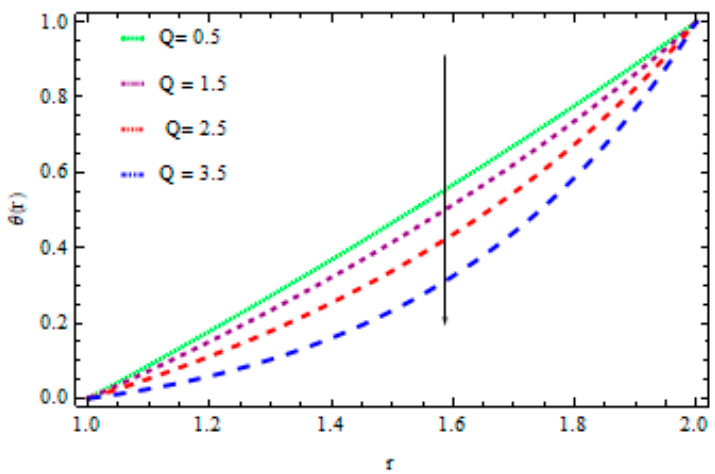
Figure 10. The influence of Q on temperature when B r = 0.1, N = 0.2, K p = 0.5, ε = 1.5.